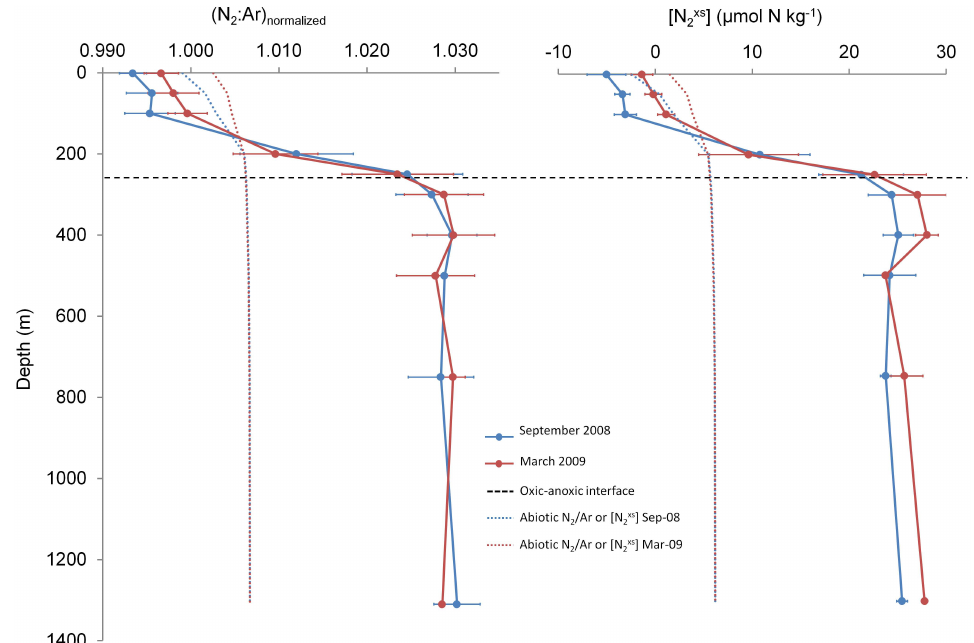
Fig. 5. Profiles of normalized N 2 /Ar ratios and [N xs ] in the Cariaco Basin during September 2008 and March 2009. Background (abiotic) 2 N 2 /Ar ratios and [N xs ] were estimated using data collected at BATS (see Sect. 2